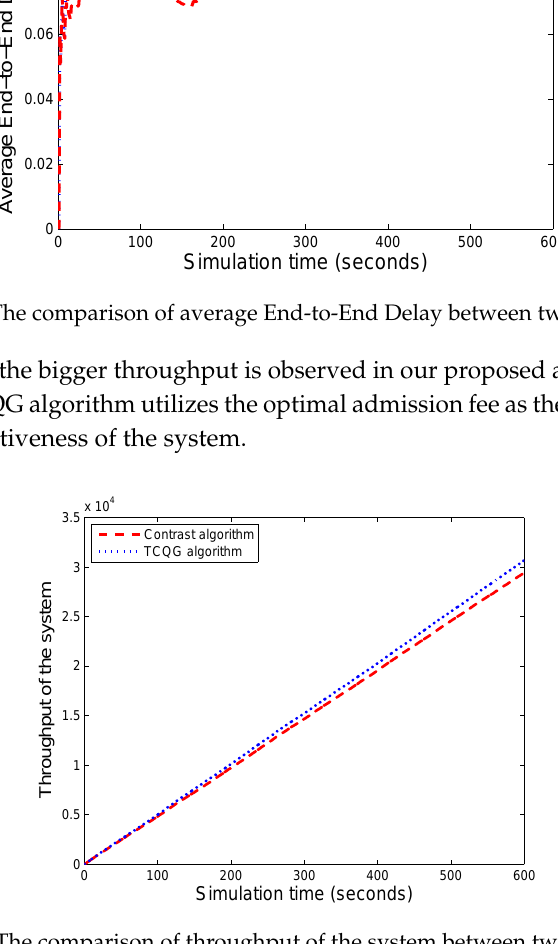
Figure 7. The comparison of throughput of the system between two